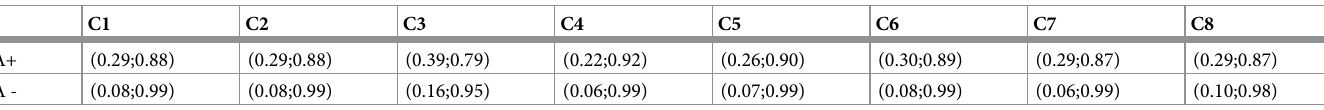
Table 12. Pythagorean fuzzy positive A + and negative ideal A −